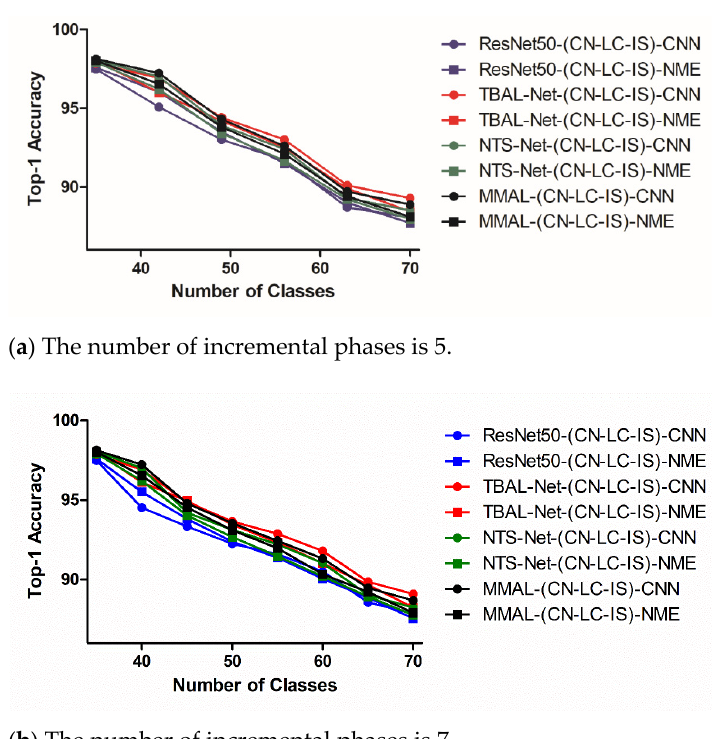
Figure 5. The performance of different number of incremental phases on FGVC-Aircraft.